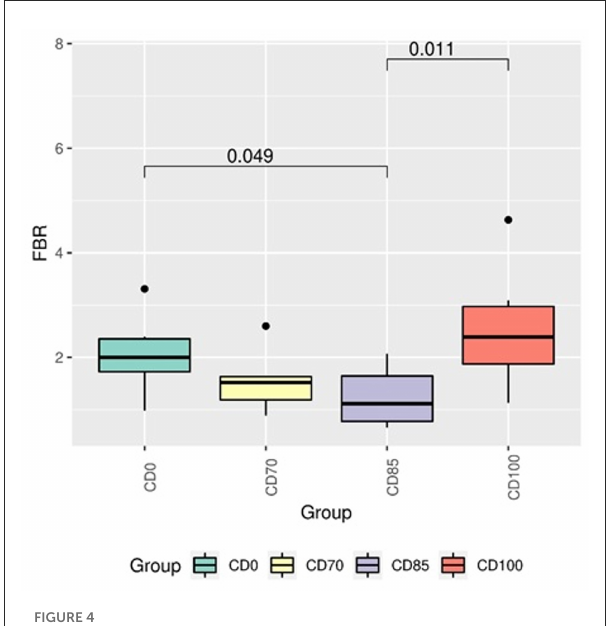
FIGURE4 Firmicutes:Bacteroidetes ratio in finisher pigs fed 1 of 4 dietary treatments: a control diet containing isolated phytase and xylanase valued at 40 kcal of ME/kg (CD0), CD0 + β -mannanase (0.3 g/kg valued at 30 kcal of ME/kg) (CD70), CD0 + β -mannanase (0.3 g/kg valued at 45 kcal of ME/kg) (CD85), and CD0 + β -mannanase (0.3 g/kg valued at 60 kcal of ME/kg) (CD100). Data are averages of 6 pigs per dietary treatment. Means differed by Wilcoxon test ( P <